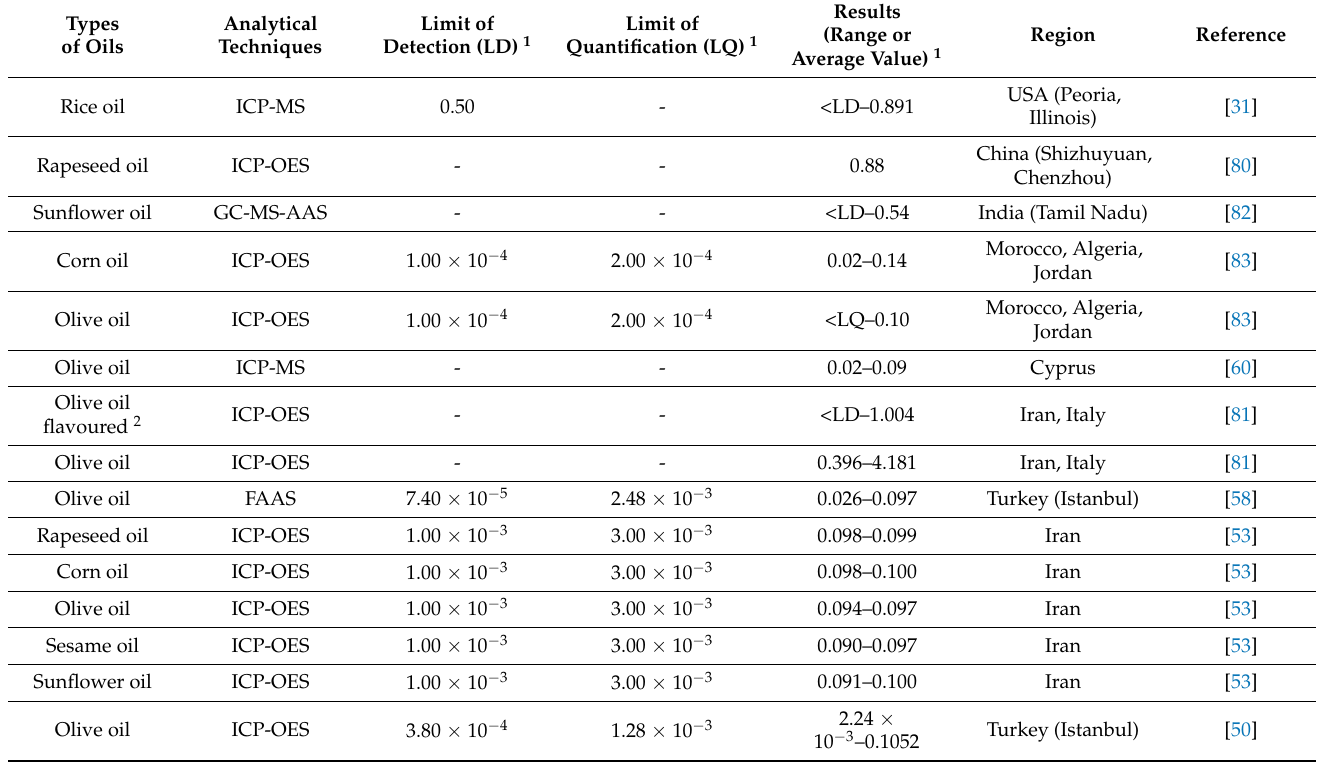
Table 3. Cadmium (Cd) content in edible vegetable oils, expressed in